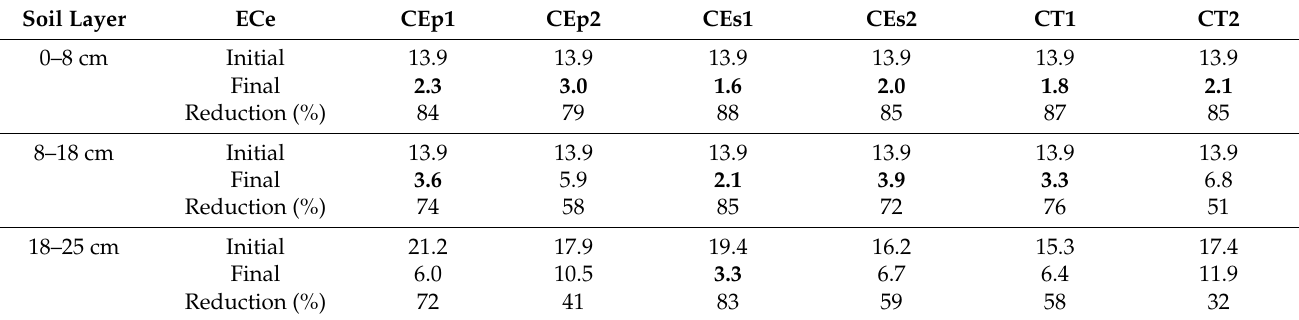
Table 3. Soil electrical conductivity (ECe, dS/m) in 0–8, 8–18 and 18–25 cm soil layers at the beginning (Initial) and end (Final) of the experiment in the six columns. CT1 and CT2 are the columns with bare soil, CEs1 and CEs2 are the columns cultivated with seasonal E. stagnina and CEp1 and CEp2 are the columns cultivated permanently with E. stagnina